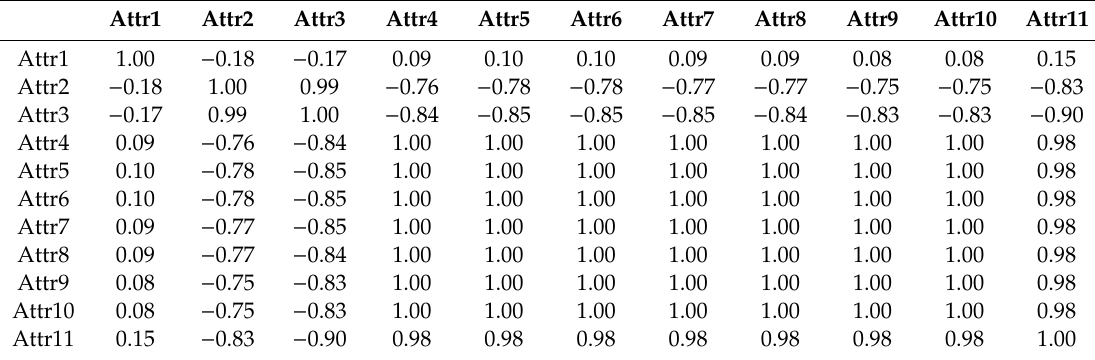
Table 1. Correlation coefficient matrix.